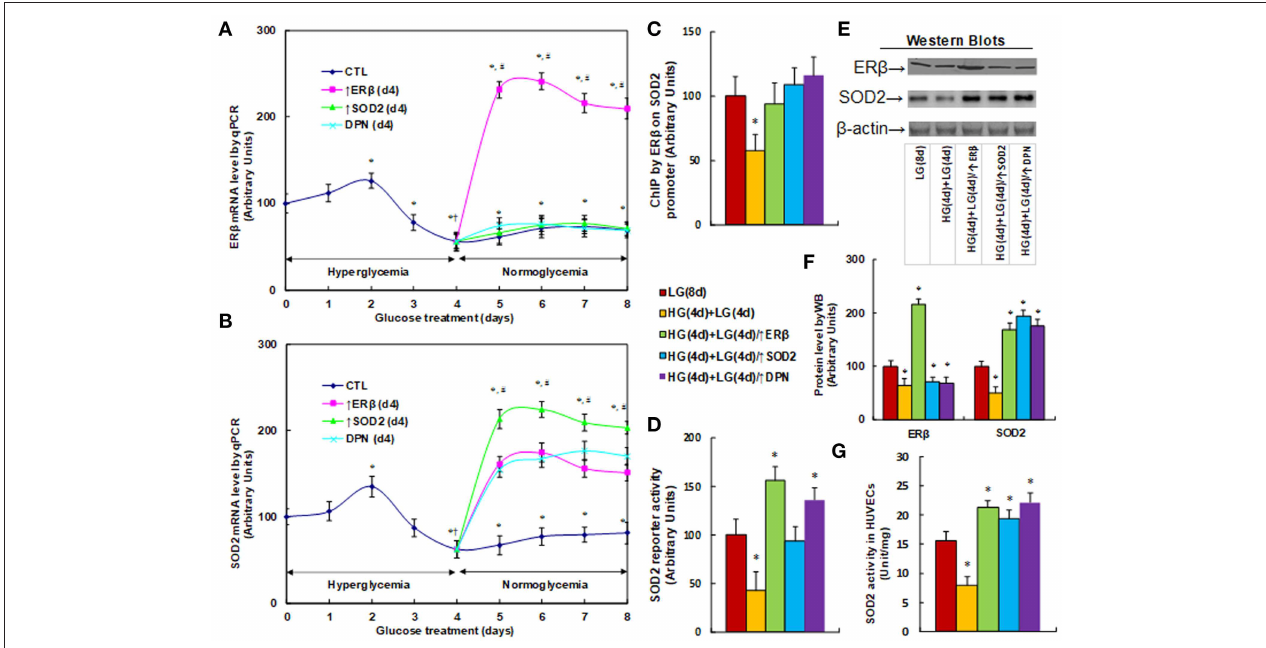
FIGURE 2 | ER β expression diminishes hyperglycemia-induced persistent SOD2 suppression. (A,B) HUVECs were incubated in hyperglycemia (25mM glucose) for 4 days, and then switched to normoglycemia (5mM glucose) for an additional 4 days. On day 4, cells were either infected by empty vector (CTL), ER β lentivirus (ER β ↑ ), or SOD2 lentivirus (SOD2 ↑ ), or treated by 100 µ M ER β agonist (DPN) for a subsequent 4 days, and the cells were harvested for mRNA analysis of ER β (A) and SOD2 (B) , n = 4. * P < 0.05, vs. day 0 group; † P < 0.05, vs. day 3 group; # P < 0.05, vs. day 4 group. (C-G) The HUVECs cells were treated either in normoglycemia (5mM) for 8 days (LG(8d)), or in hyperglycemia (HG in 25mM glucose) for 4 days followed by normoglycemia (LG in 5mM glucose) for an additional 4 days (HG(4d) + LG(4d)), or the cells were infected at day 4 by either ER β lentivirus (HG(4d) + LG(4d)/ER β ↑ ), or SOD2 lentivirus (HG(4d) + LG(4d)/SOD2 ↑ ), or treated by ER β agonist (HG(4d) + LG(4d)/DPN) for a subsequent 4 days, and the cells were harvested for further analysis. (C) ChIP analysis by ER β antibody on SOD2 promoter, n = 4. (D) SOD2 reporter activity assay, n = 5. (E) Representative picture for western blots. (F) Protein quantitation for (E) , n = 4. (G) SOD2 activity assay, n = 5. * P < 0.05, vs. LG(8d) group. Data are expressed as mean ± SEM.